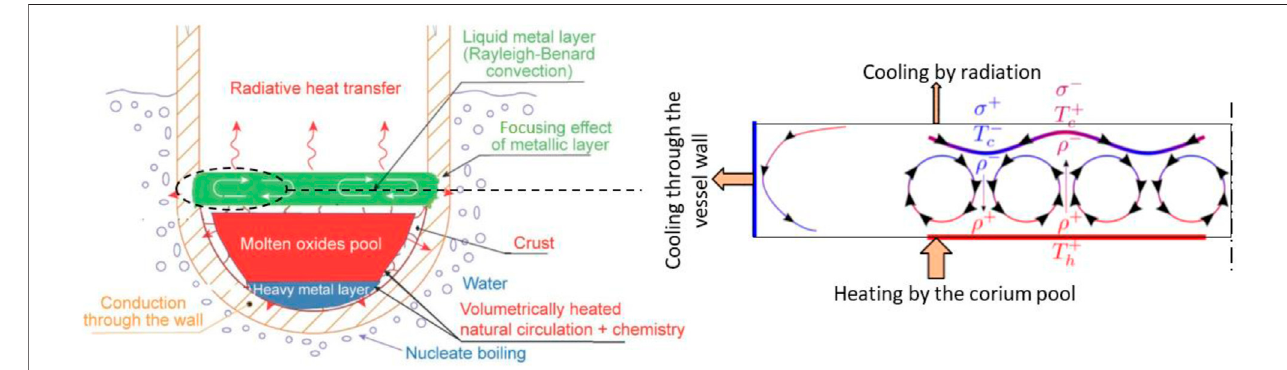
FIGURE 7 | Typical IVR con fi guration. Left: strati fi ed corium pool and typical transfer phenomena (Ma, et al., 2016). Right: zoom on the Bénard-Marangoni fl ow at the surface of the thin upper metallic layer, according to surface tension evolution with temperature (courtesy from R. Le